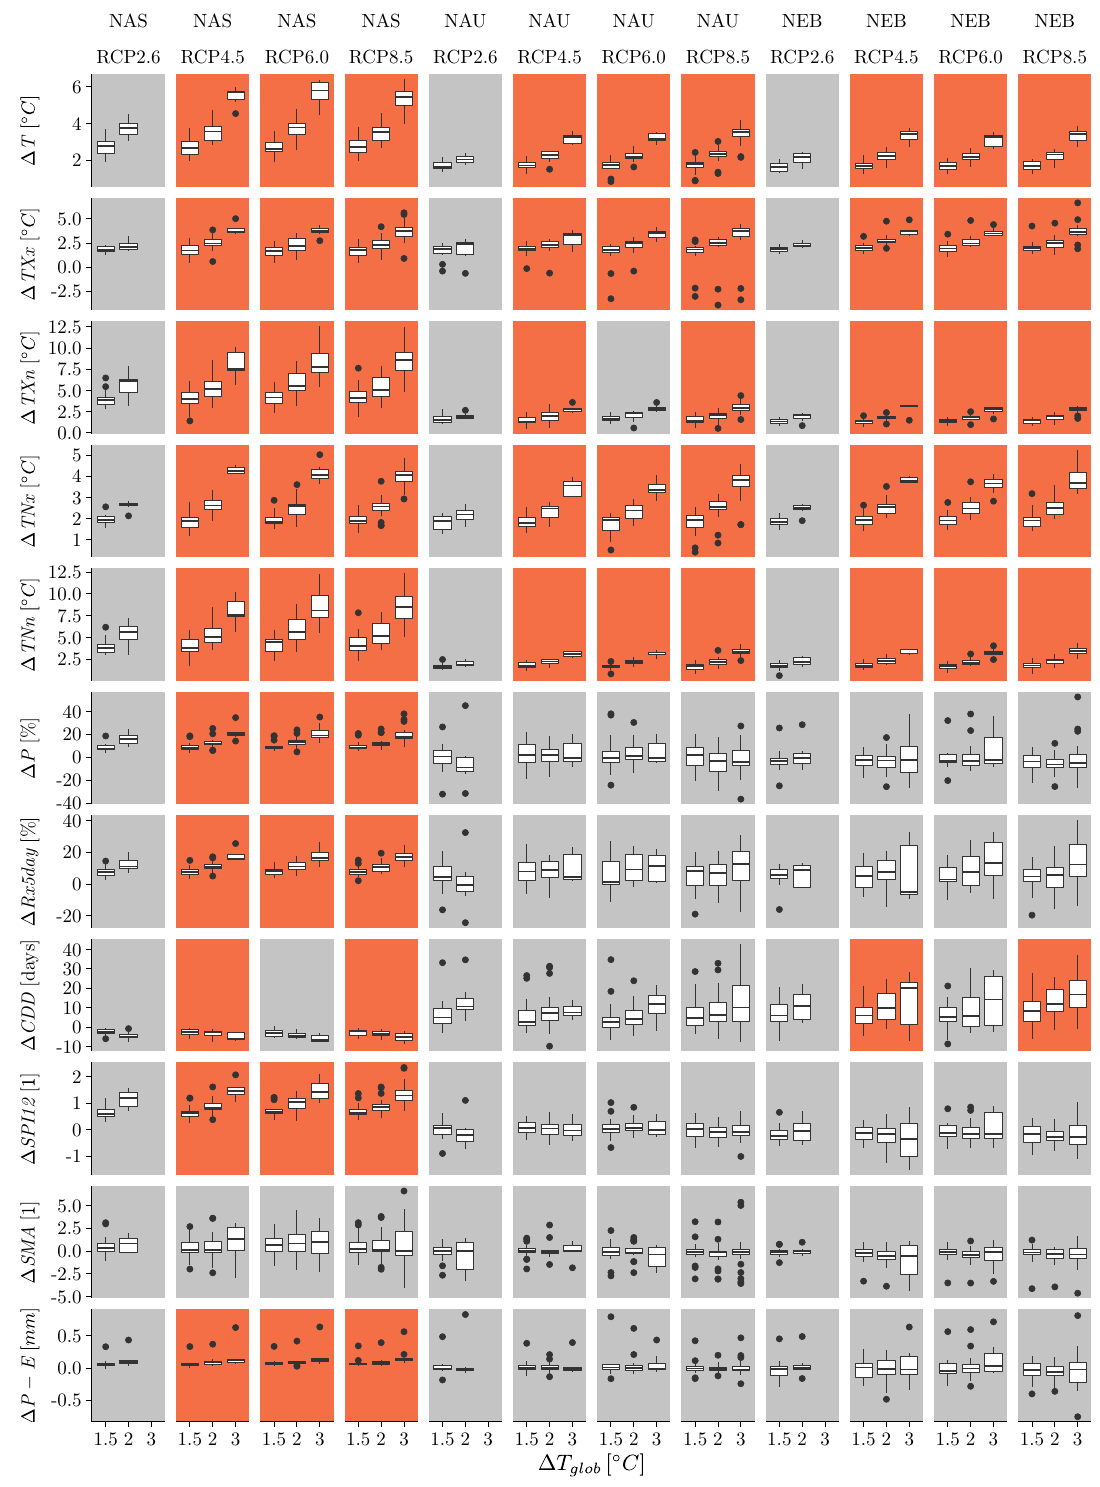
N o significant difference in between the distributions of for and S ignificant difference in between the distributions of for and Figure A3. Like Fig. A1 but for SREX regions NAS, NAU, and